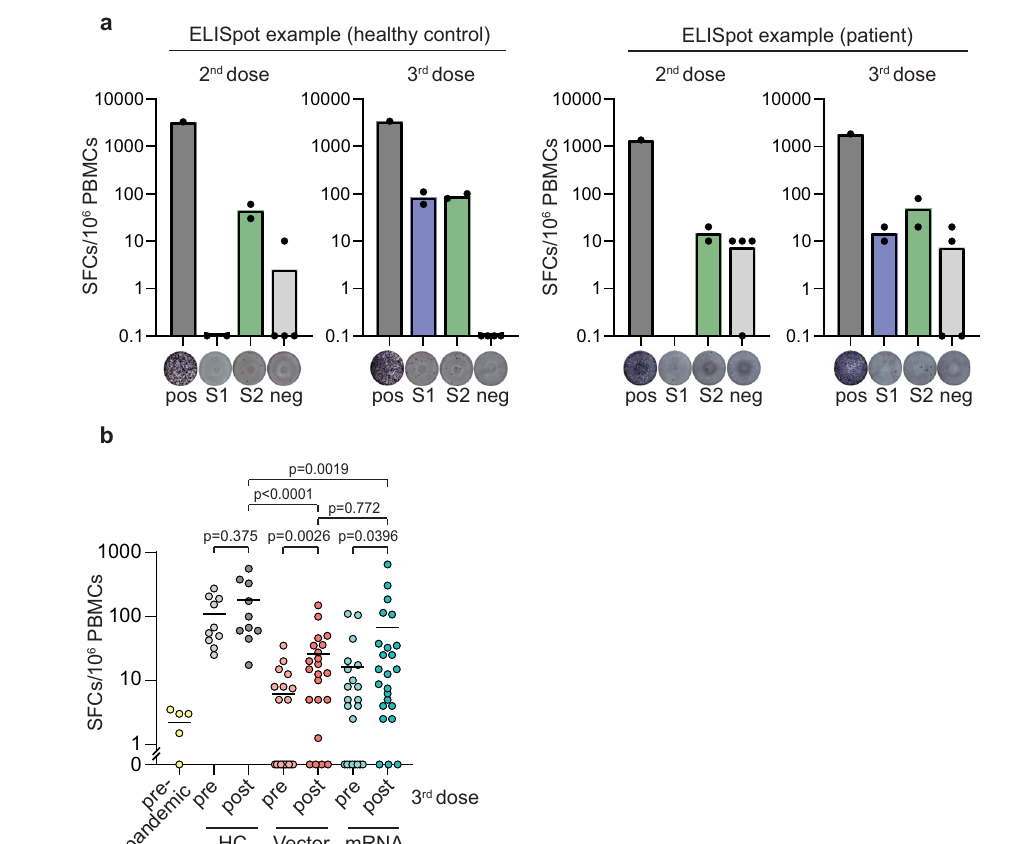
before(pre, n =41)and1weekafter(post, n =46)thirdvaccinationwithvectorand mRNA vaccine. Circles show sum of total responses from S1 and S2 peptide pools. Verticallinesindicatethemean.PairedWilcoxontestwasusedtocomparesamples before and after booster vaccination. Mann – Whitney-U test was utilized to com- pare cellular vaccine responses. All tests were two-sided and no correction for multiple testing was performed. Source data are provided as a Source Data fi